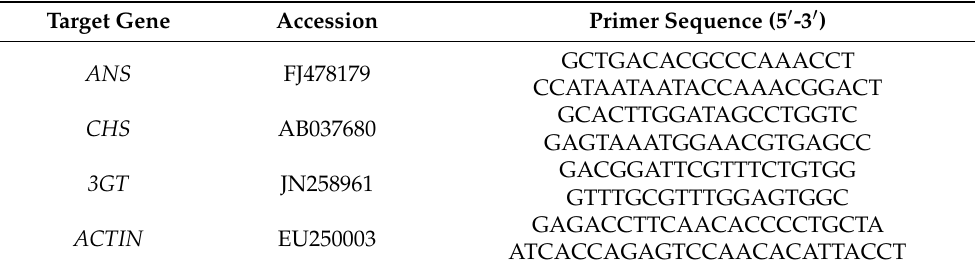
Table A1. A Primer information of three candidate genes related to flavonoid biosynthesis used for qPCR.